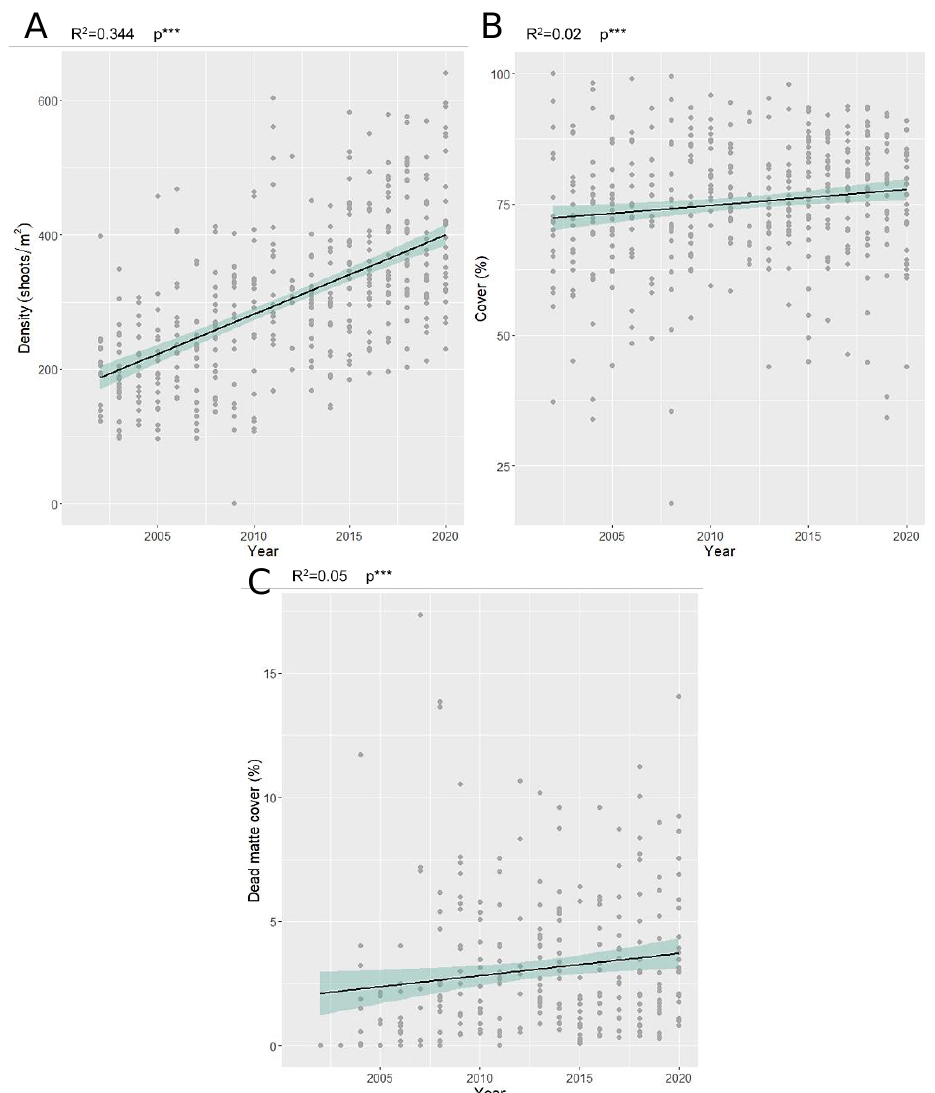
Figure 2. Trends in the shoot density ( A ), percentage of P. oceanica cover ( B ), and percentage of dead matte ( C ) over time. Fitted lines from generalized additive models are presented with 95% confidence intervals. Coefficient of determination (R 2 ) and needed transformations are shown. Results of linear regression: *** = p < 0.005.